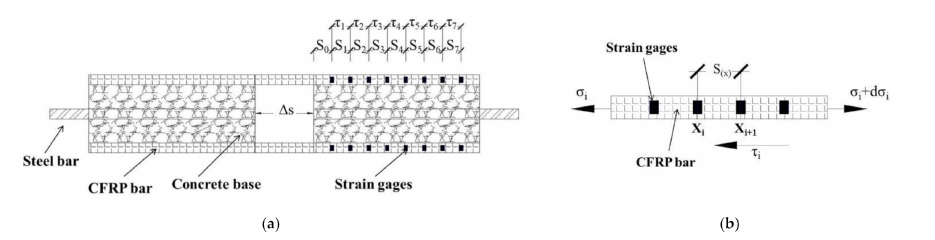
Figure 4. Distribution of strain gages on bonding slip specimen: ( a ) Layout of strain gauges in pull-out tests; ( b ) Schematic diagram of free body.